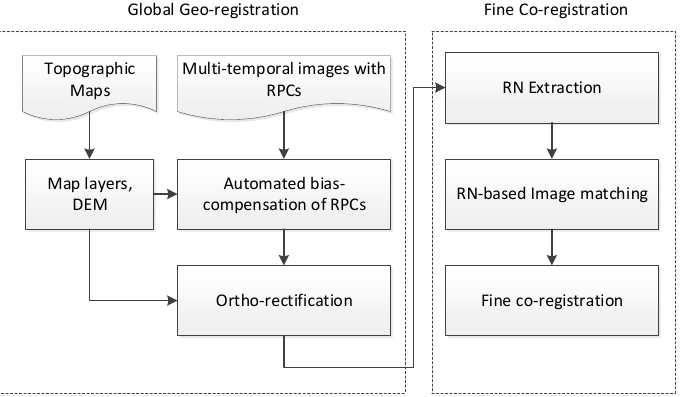
Figure 1. Flowchart of the automated geo/co ‐ registration approach for very ‐ high ‐ resolution (VHR) time ‐ series data set. RPCs—rational polynomial coefficients; DEM—digital elevation model; RN— registration